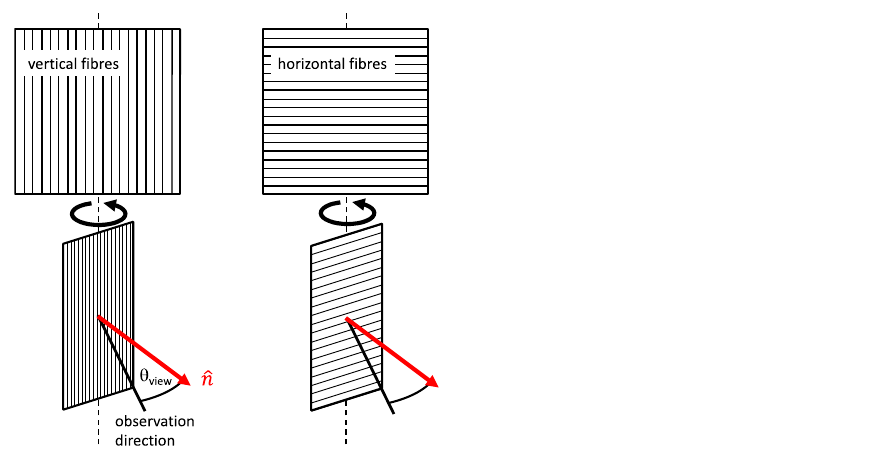
Figure 7. Wood observations at different azimuthal angles θ view are influenced by the fibre orienta-